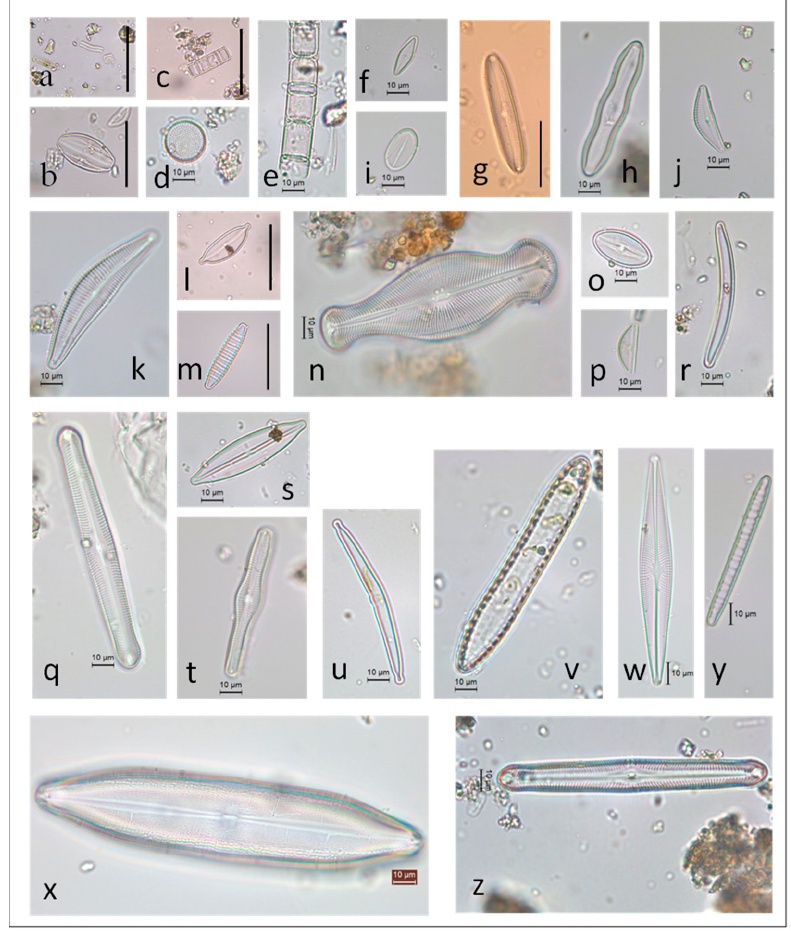
Figure 4. ( a ) Achnanthidium minutissimum , ( b ) Amphora ovalis , ( c ) Aulacoseira italica , ( d ) A. lacustris , ( e ) A. valida , ( f ) Brachysira brebissonii , ( g ) Caloneis alpestris , ( h ) C. silicula , ( i ) Cocconeis placentula var. euglypta, ( j ) Cymbella affinis , ( k ) C. cistula , ( l ) Cymbopleura amphicephala , ( m ) Diatoma vulgaris , ( n ) Didymosphenia geminata , ( o ) Diploneis elliptica , ( p ) Encyonema minutum , ( q ) Epithemia gibba , ( r ) Eunotia mucophila , ( s ) Frustulia crassinervia , ( t ) Gomphonema montanum , ( u ) Hannaea arcus , ( v ) Iconella linearis , ( w ) Navicula radiosa , ( x ) Neidium dubium , ( y ) Odontidium hyemale , and ( z ) Pinnularia major . Scale bar: 10 μ m.